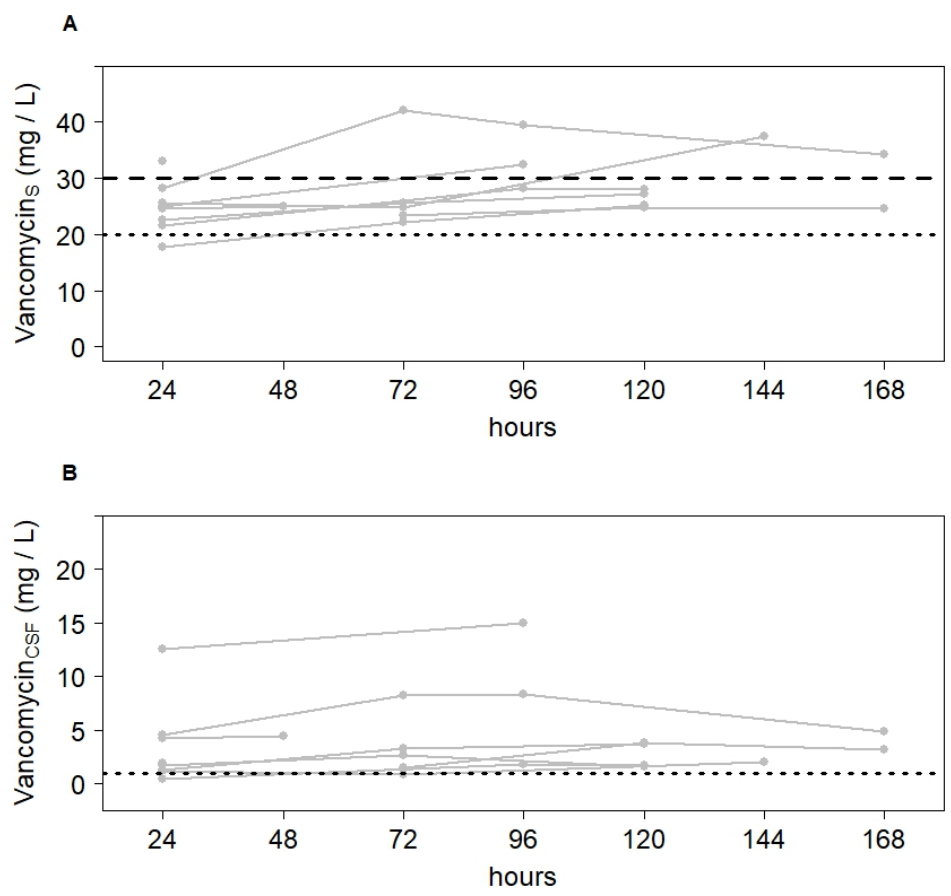
Figure 3. Variation of vancomycin concentrations in serum ( A ) and CSF ( B ) over the first 7 days of treatment. Narrow lines depict the course of every individual patient (n = 9). The dotted line depicts the lower and the dashed line the upper limit of the target concentration.